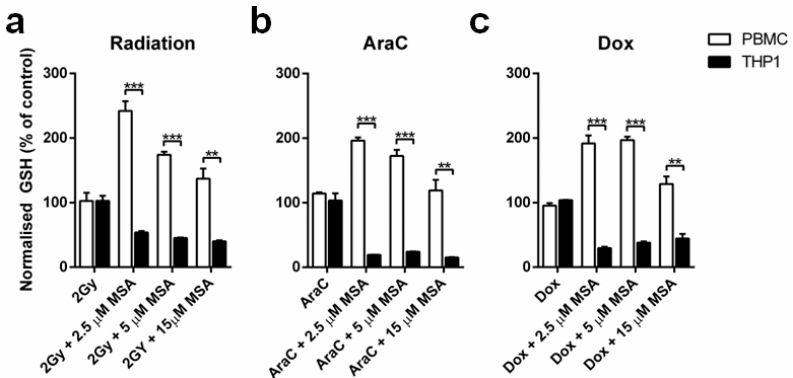
Figure 3. MSA-induced GSH alterations are maintained in the presence of therapeutic treatments.